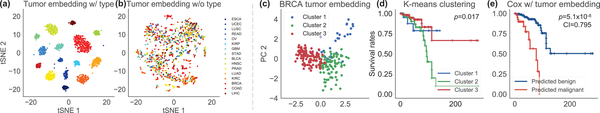
(a) t-SNE of full tumor embedding et. (b) t-SNE of stratified tumor embedding (et-es). (c) PCA of tumor embedding shows internal subtype structure of BRCA tumors. Color lablels the group index of k-means clustering. (d) KM estimators of the three breast cancer groups. (e) Cox regression using tumor embeddings.